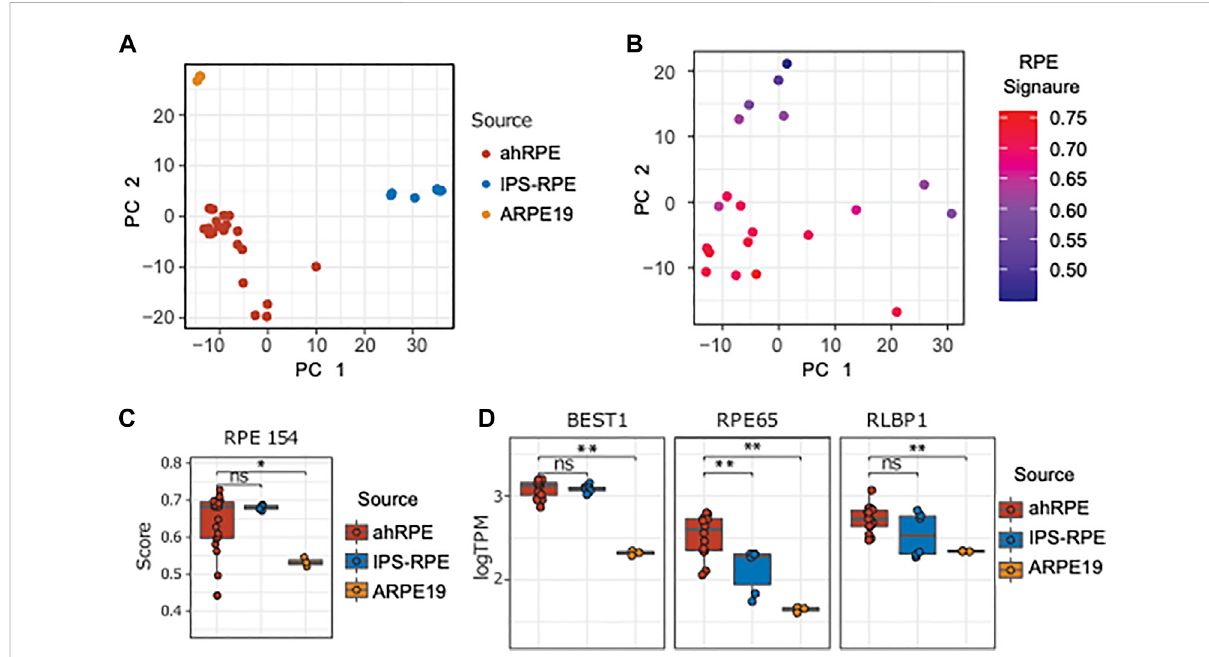
FIGURE 3 Comparison of ahRPE, ARPE-19, and iPSC-RPE transcriptomes. (A) Principal component analysis of RPE samples shows clean separation of source types. (B) Principal component analysis for ahRPE samples, with color indicating RPE signature expression for each sample (ssGSEA). (C)